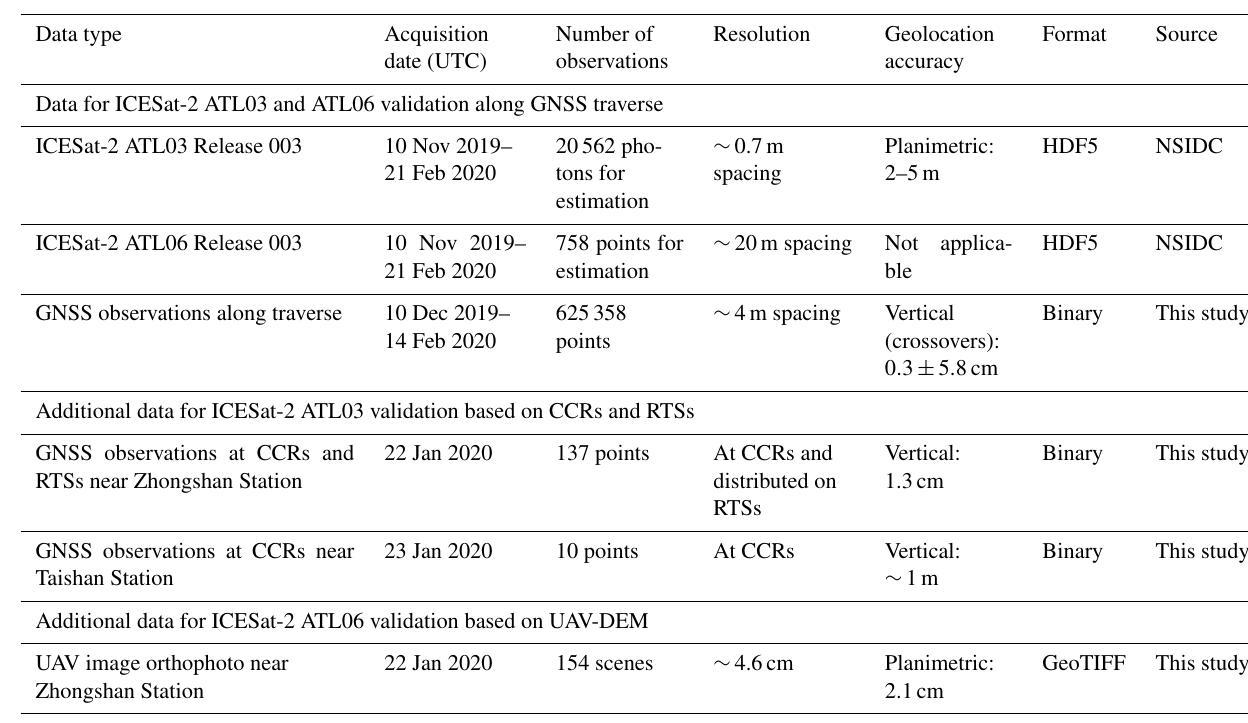
Table 1. Summary of the ICESat-2, GNSS, and UAV observations used in this study. Data type Data for ICESat-2 ATL03 and ATL06 validation along GNSS traverse ICESat-2 ATL03 Release 003